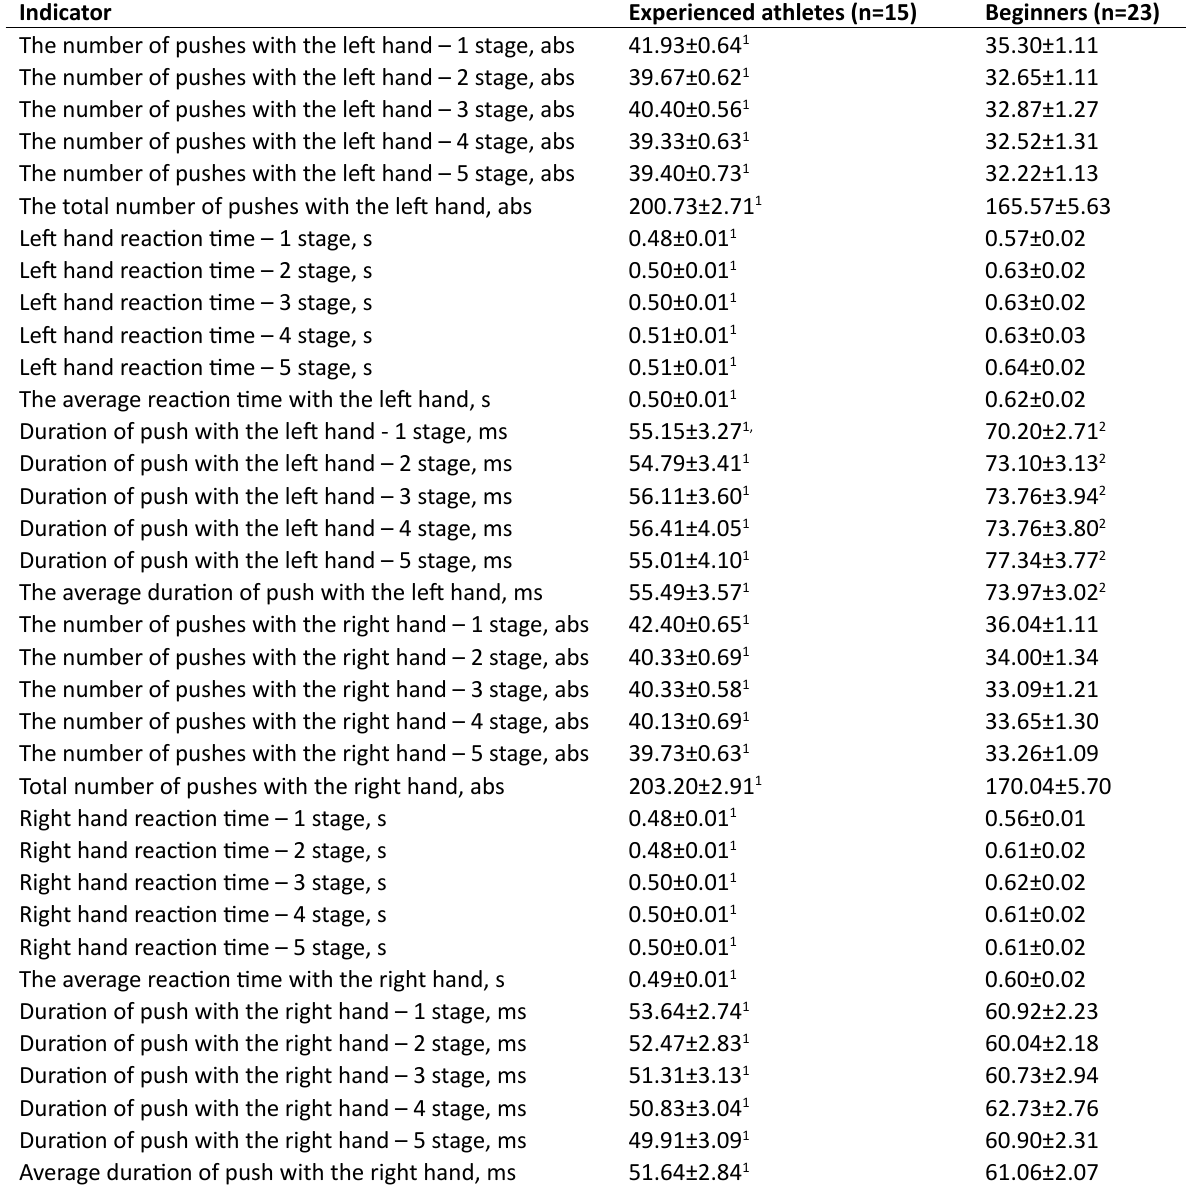
Table 1. Simple reaction performance for functional asymmetry by athletes with different skills’